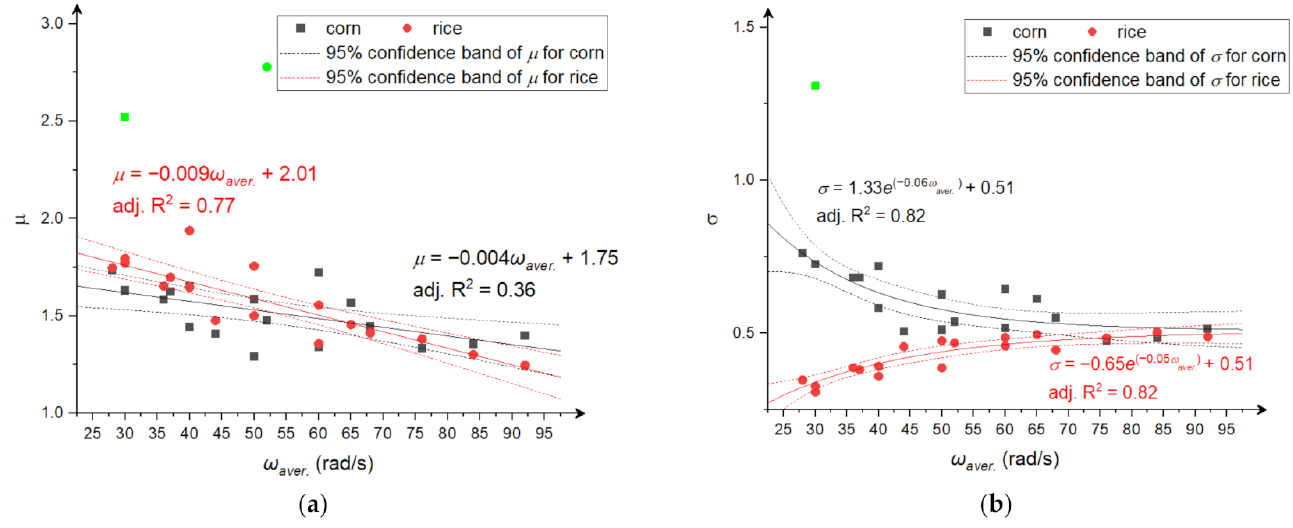
Figure A1. The dependence between µ (average value) and σ (variance) and average angular disc velocities during comminution; ( a ) µ (average value); ( b ) σ (variance). The green points are outliers not included in the